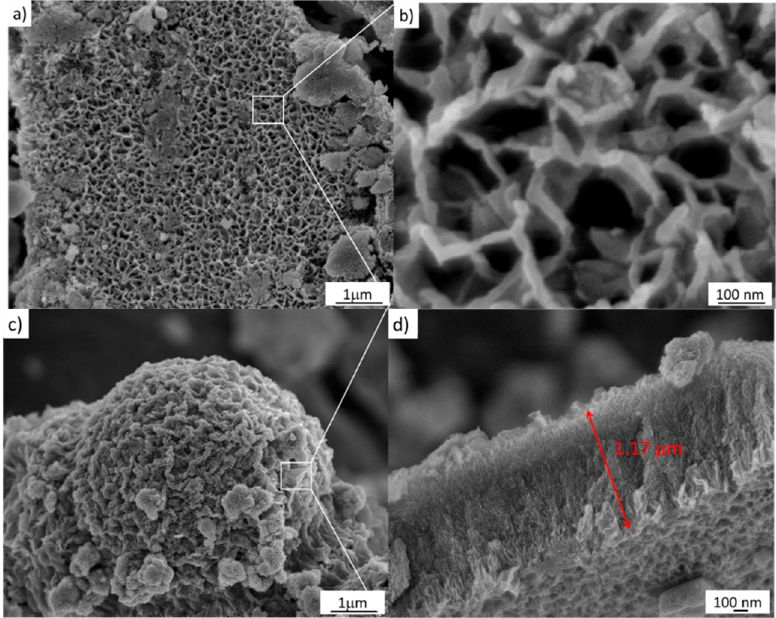
Figure 5. FESEM images of the samples treated hydrothermally at 110 °C for 24 h. ( a , b ) 1 M NaOH; ( c , d ) 2 M NaOH.